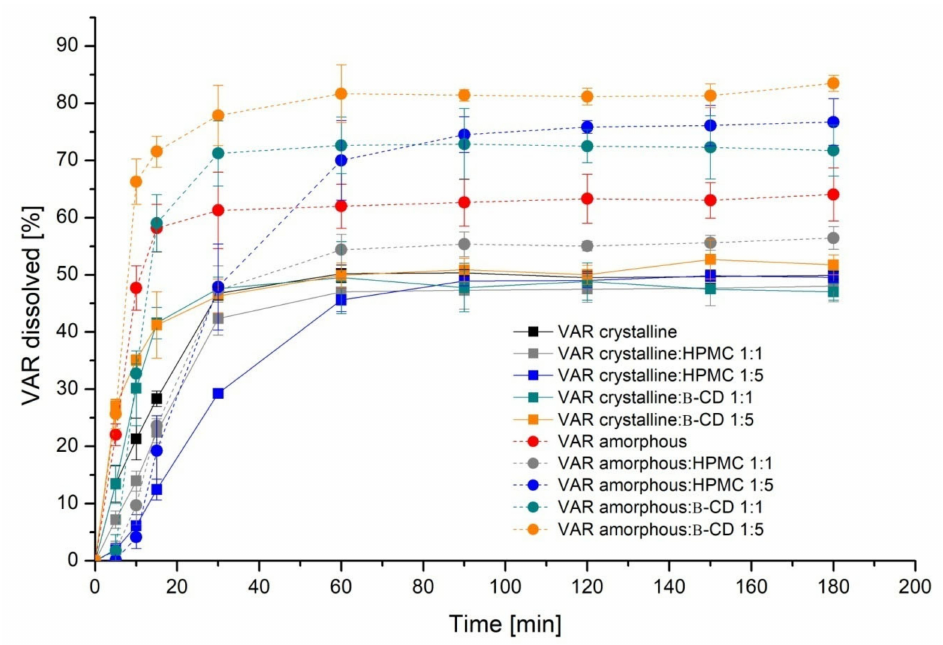
Figure 5. Dissolution profiles of crystalline and amorphous forms of VAR and its systems with excipients (HPMC and β -CD) at 1:1 and 1:5 API:excipient